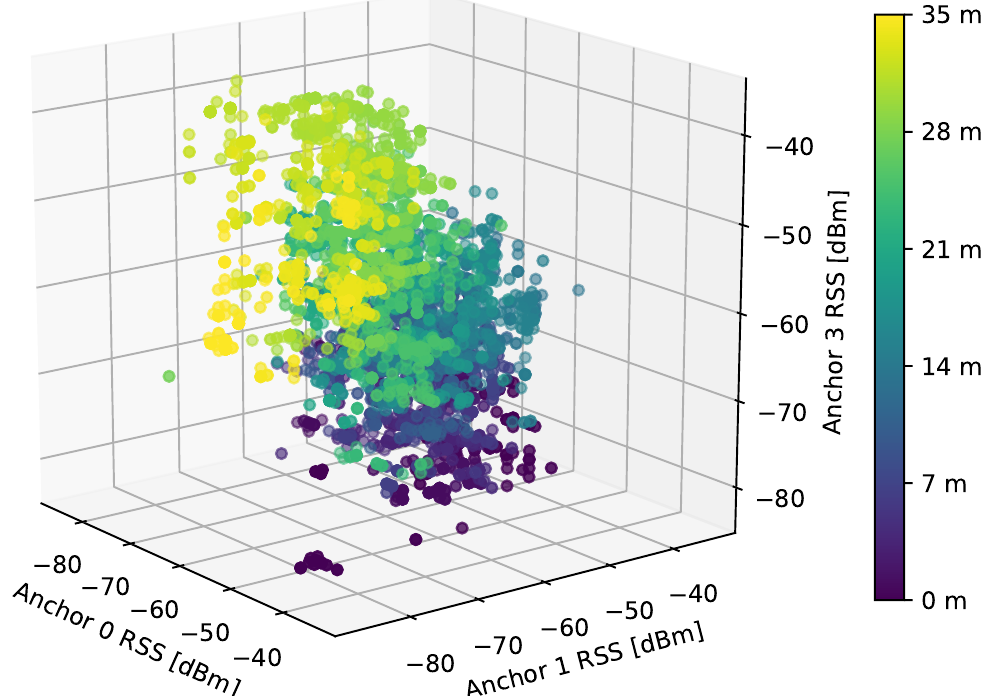
Figure 5. A visualisation of RSS values received from three anchors in a three-dimensional space, channel 37 only. The color of the points represents the location distance. For simplicity, only 20% of data has been used in the